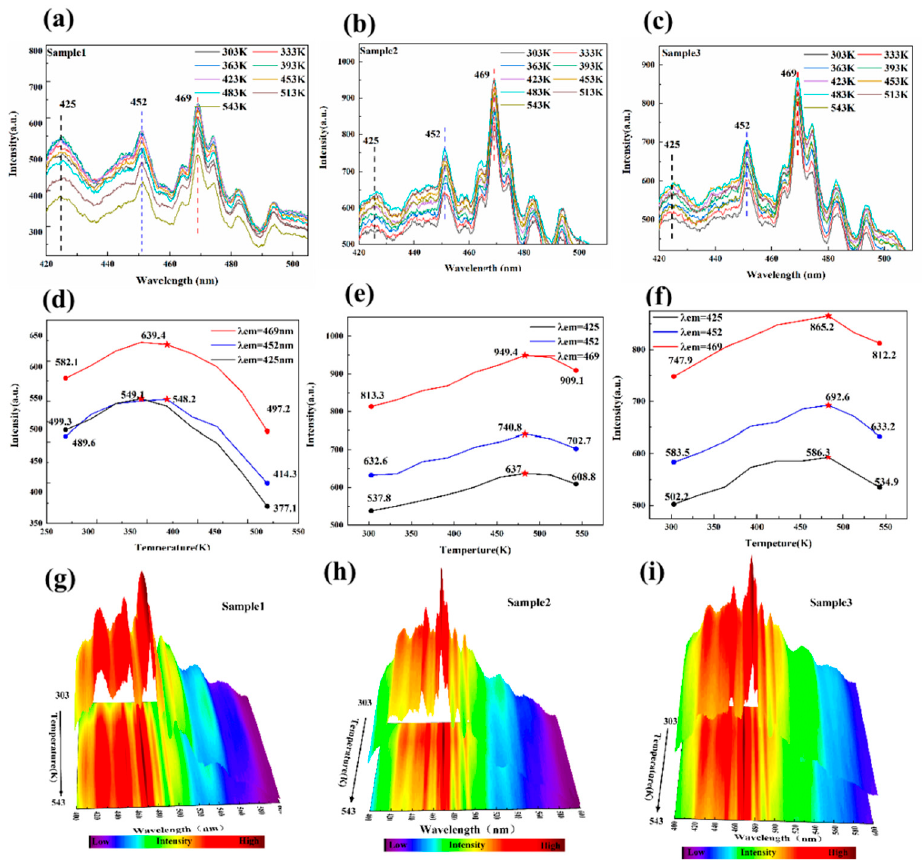
Figure 9. ( a – c ) The two-dimensional fluorescence spectra of fluorite of the three samples in the temperature range from 303 to 543 K. ( d – f ) The variation of luminescent intensity with the temperature at the three main emission peaks of 425, 452, and 469 nm ( λ ex = 238 nm). ( g – i ) The three-dimensional spectra of fluorite of the three samples in the temperature range from 303 to 543 K, respectively. Figure 10a–c reveal the emission colors and CIE chromaticity coordinates (x, y) of the three samples at 303, 393, 483, and 543 K. As the temperature continued to rise, the lumi- nescent color of fluorite showed a red shift, but remained in the blue area. During the heating process, fluorite exhibited excellent luminescence stability. Mott formula was used to describe the thermal behavior of sample 3. The strong emission peaks at 469 and 493 nm were selected for discussion.